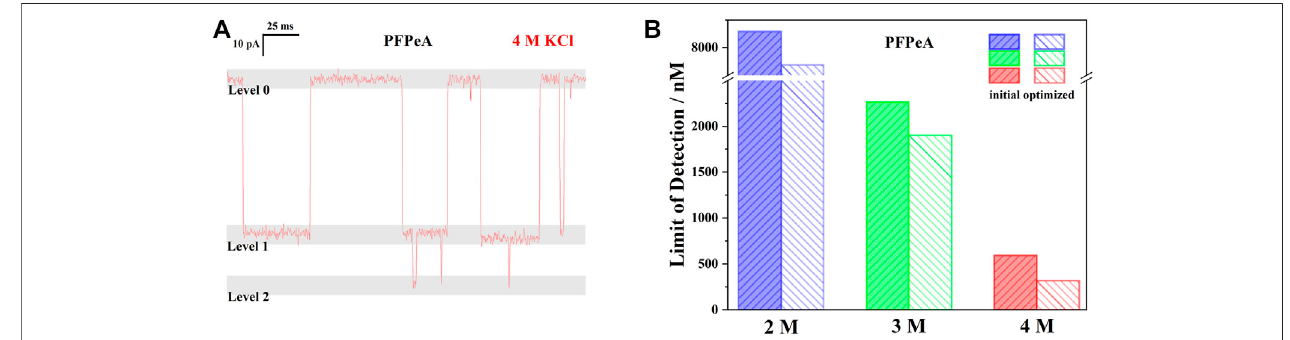
FIGURE 5 | (A) A typical current trace of PFPeA in 4 M KCl at -50 mV to highlight the in fl uence of level 2 signal on quanti fi cation. (B) The initial and optimized limit LOD of PFPeA at − 50 mv in 2, 3, and 4 M KCl electrolyte.